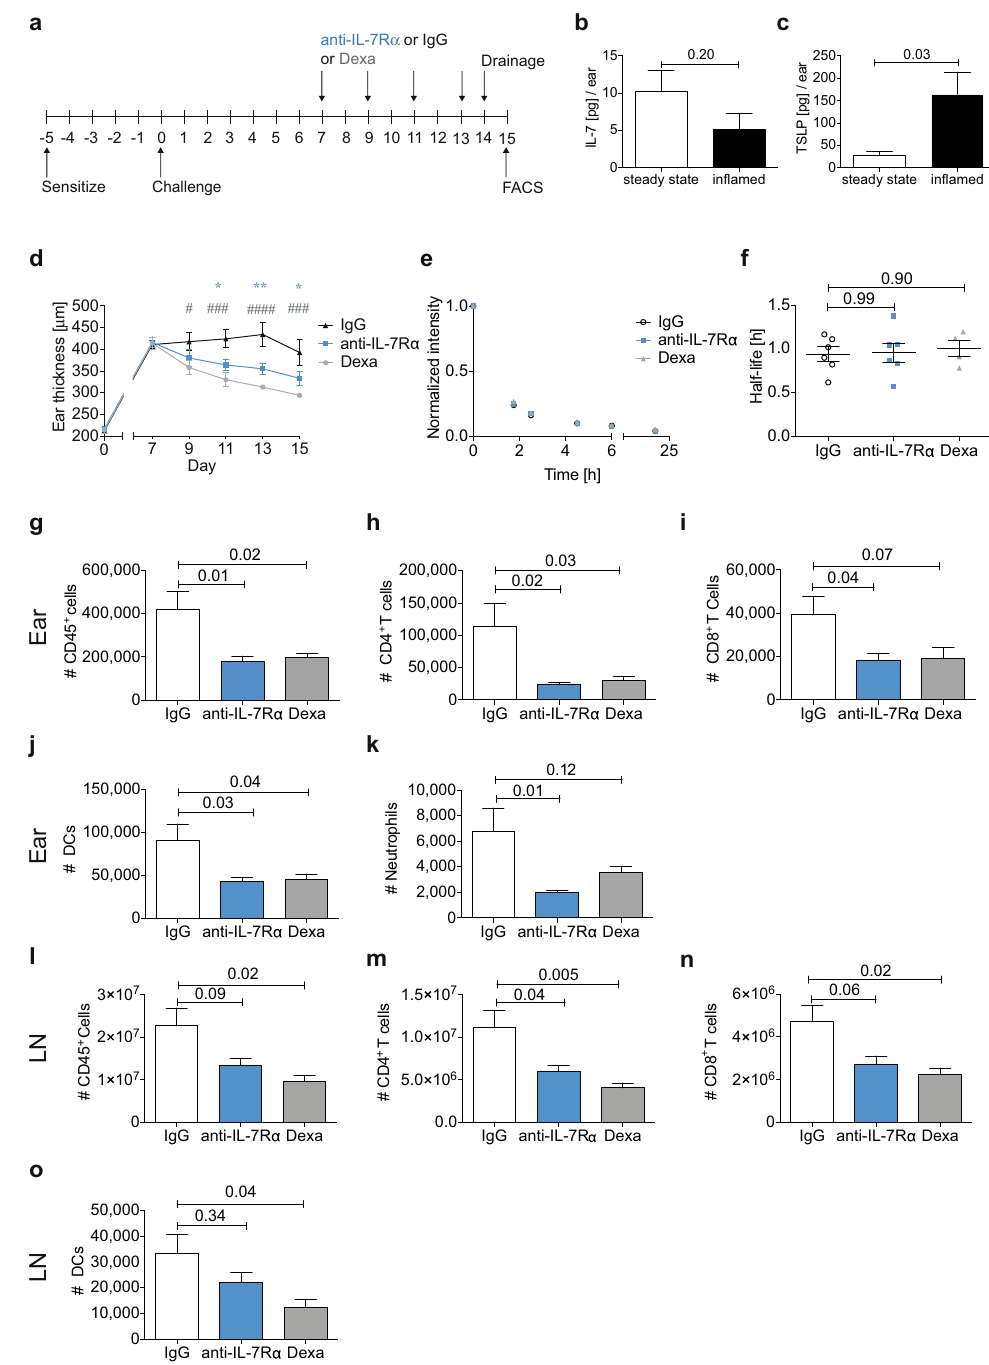
Figure 3. Anti-IL-7R α treatment ameliorates oxazolone-induced inflammation in K14-VEGF-A mice. ( a ) Hemizygous K14-VEGF-A mice were sensitized with oxazolone on the belly and paws. Five days later their ears were challenged with oxazolone. Mice were randomized into treatment groups on day 7 and treated i.p. with anti-IL-7R α antibody, corresponding IgG control, or with dexamethasone (Dexa) on days 7, 9, 11, and 13. The ear thickness was measured on each treatment day. Lymphatic drainage was measured on day 14 after challenge, and the mice were sacrificed on day 15. Immune cell infiltration in the ear skin and dLNs was analyzed by FACS. ( b ) IL-7 and ( c ) TSLP protein levels were measured from ear skin lysates on day 8 (n = 4 per group). ( d ) Ear thickness measurements over the course of the treatment. P values indicated by an asterisk show comparisons between anti-IL-7R α and IgG. P values indicated by a pound sign show comparisons between Dexa and IgG. #/ * p < 0.05; ** p < 0.01 ### p < 0.001; #### p < 0.0001. ( e , f ) Lymphatic drainage analysis: ( e ) Average clearance plots of P20D800 from the ear measured by IVIS and ( f ) the calculated half-lives. FACS-based quantification of the number of ( g , l ) CD45 + cells, ( h , m ) CD4 + T cells, ( i , n ) CD8 + T cells, ( j , o ) DCs, ( k ) neutrophils measured in the ear skin ( g – k ) and in dLNs ( l – o ) on day 15. One ear per mouse and both dLNs were used for the FACS analysis. Data (mean ± SEM) from 1 out of 3 similar experiments ( d , g – k ) and data from 1 out of 2 experiments with each 5–7 mice per group ( e , f , l – q ) are